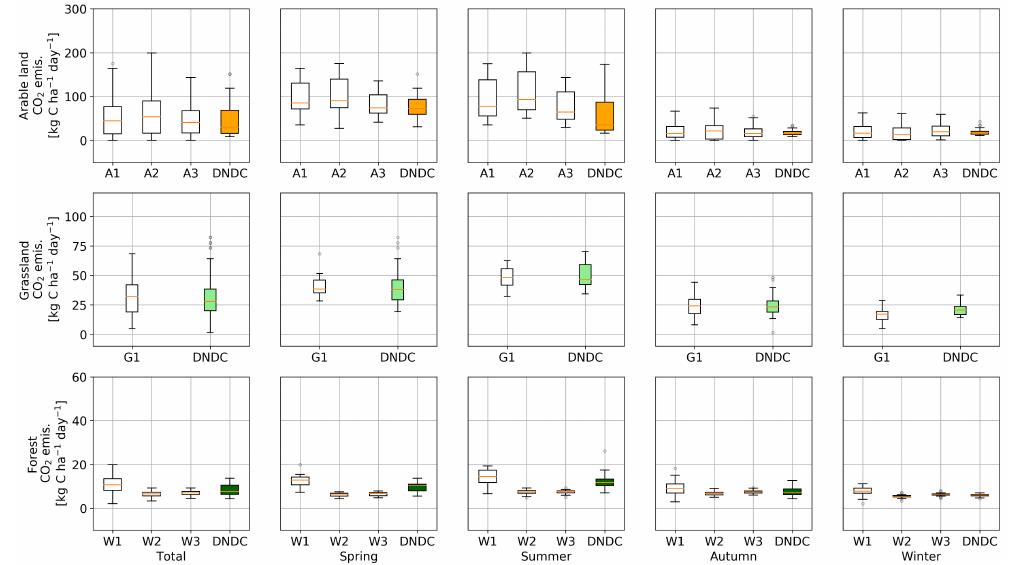
Figure 6. Observed and modelled CO 2 emissions for spring (21 March–20 June), summer (21 June–20 September), autumn (21 September– 20 December), and winter (21 December–20 March).